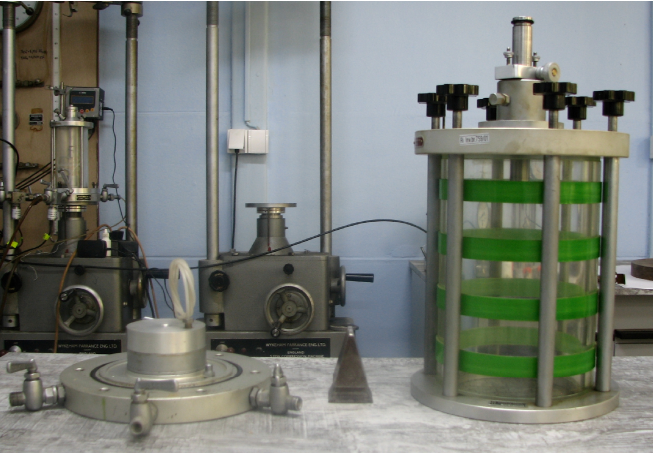
Figure 13. Basic equipment parts for underwater coal mining cutting resistance testing.